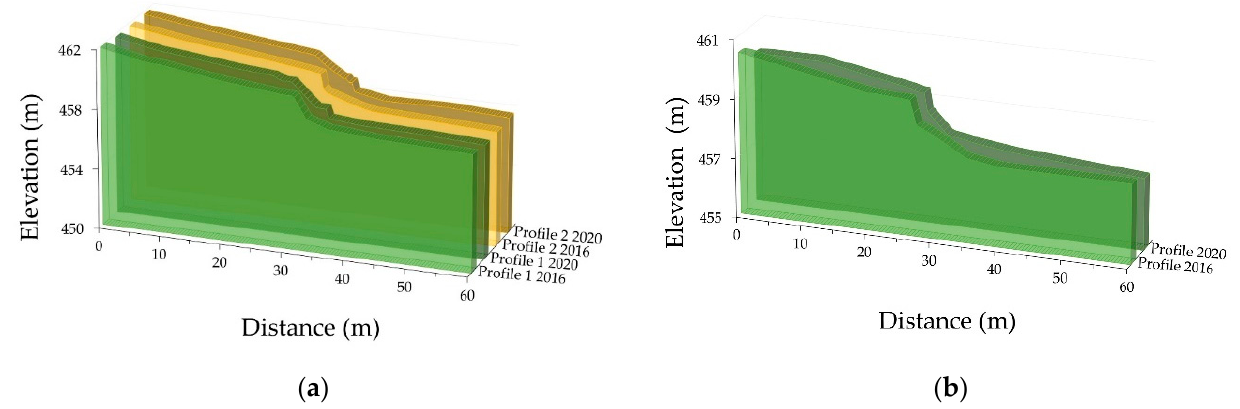
Figure 9. Differential bathymetry: ( a ) PC1.a section; ( b ) PC2 section.